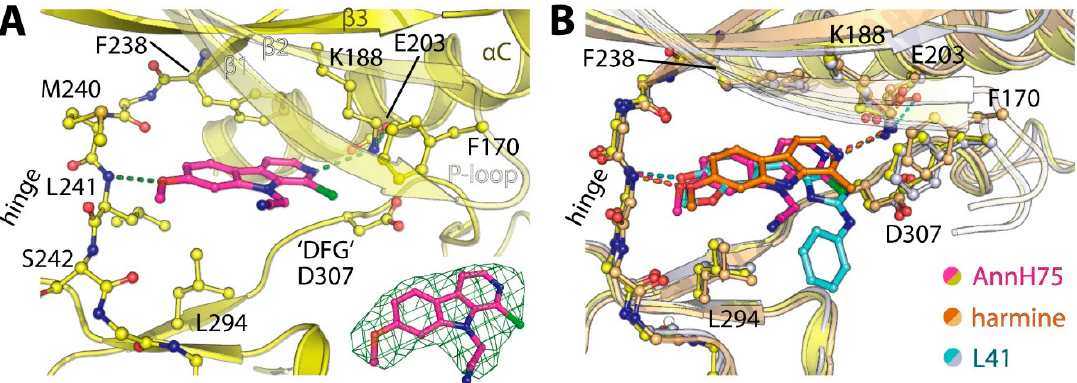
Figure 4. Crystal structure of DYRK1A in complex with AnnH75 . ( A ) Detailed view of interaction between the inhibitor and the kinase. The inset shows an electron density map for the bound inhibitor. ( B ) Structural comparison between the binding modes of AnnH75 , harmine (PDB 3ANR) and leucettine L41 (PDB 4AZE) revealed highly conserved binding modes of all inhibitors, albeit slight differences in orientation of the tricyclic core observed for AnnH75 .